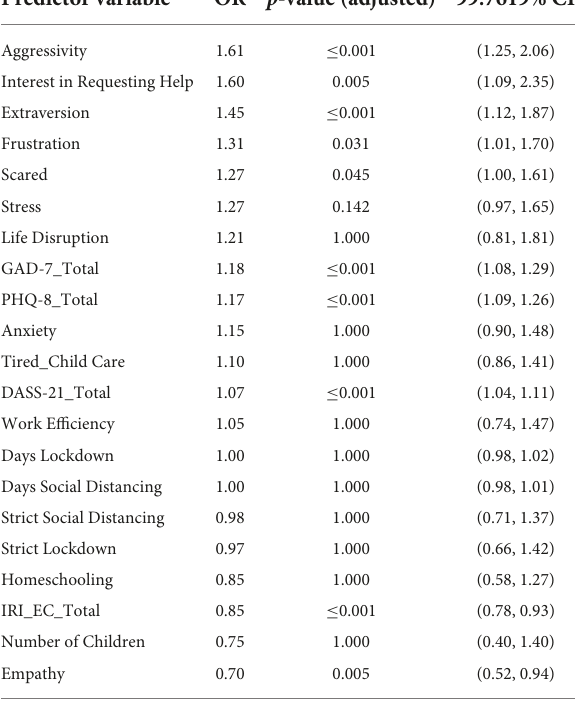
TABLE 5 (Time 3): Predictors of physical fights between partners in the unregularized regression model. Predictor